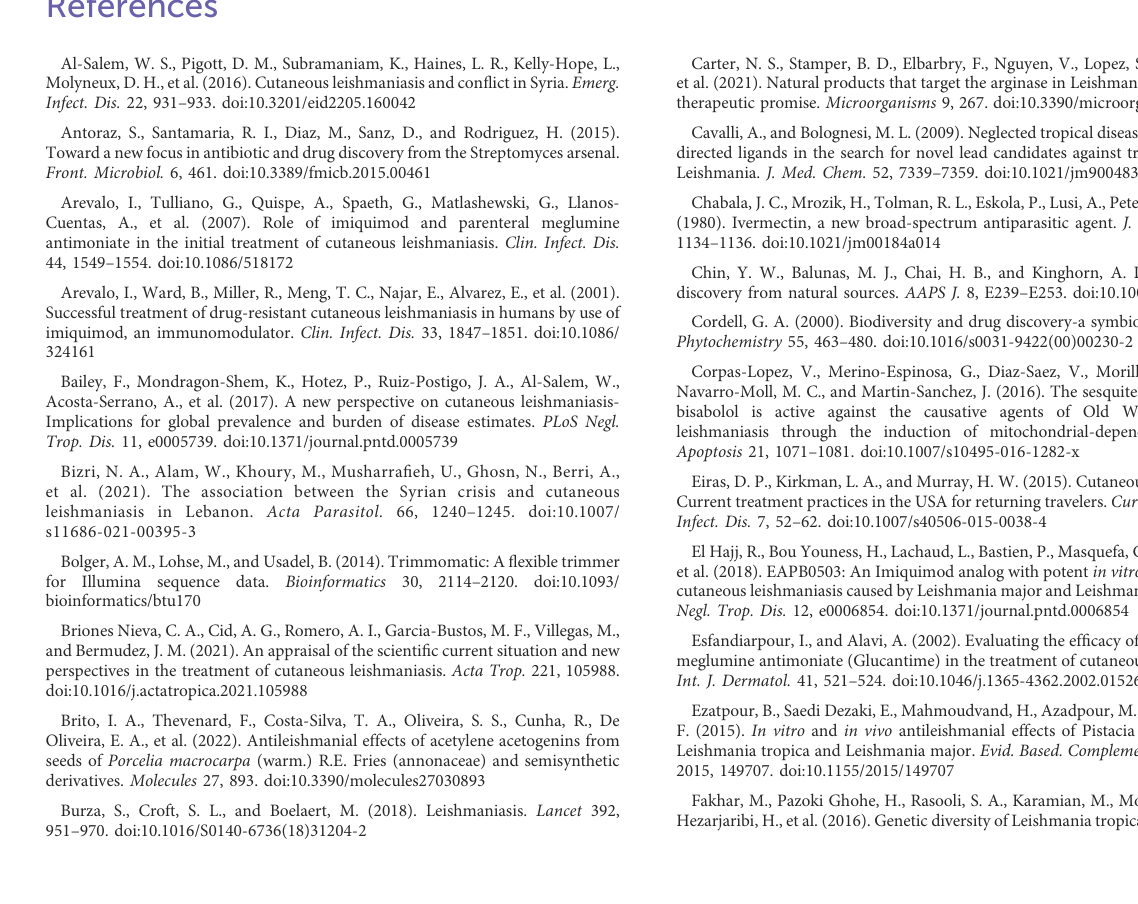
SUPPLEMENTARY FIGURE S1 Cytotoxicity testing of HAS1-F1 and HAS1-F2. Peripheral blood mononuclear cells were incubated with different concentrations of HAS1-F1 or HAS1-F2 (1, 5, or 10 μ g/ml) for 24 h. Living cells were countedusingtheTrypanBlueexclusiondyeassay.Resultsareexpressed as percentage of the untreated control (±) SEM are representative of three independent experiments. To validate statistical signi fi cance, t-tests were used, and no signi fi cance was recorded when comparing any of the treatment groups to the control